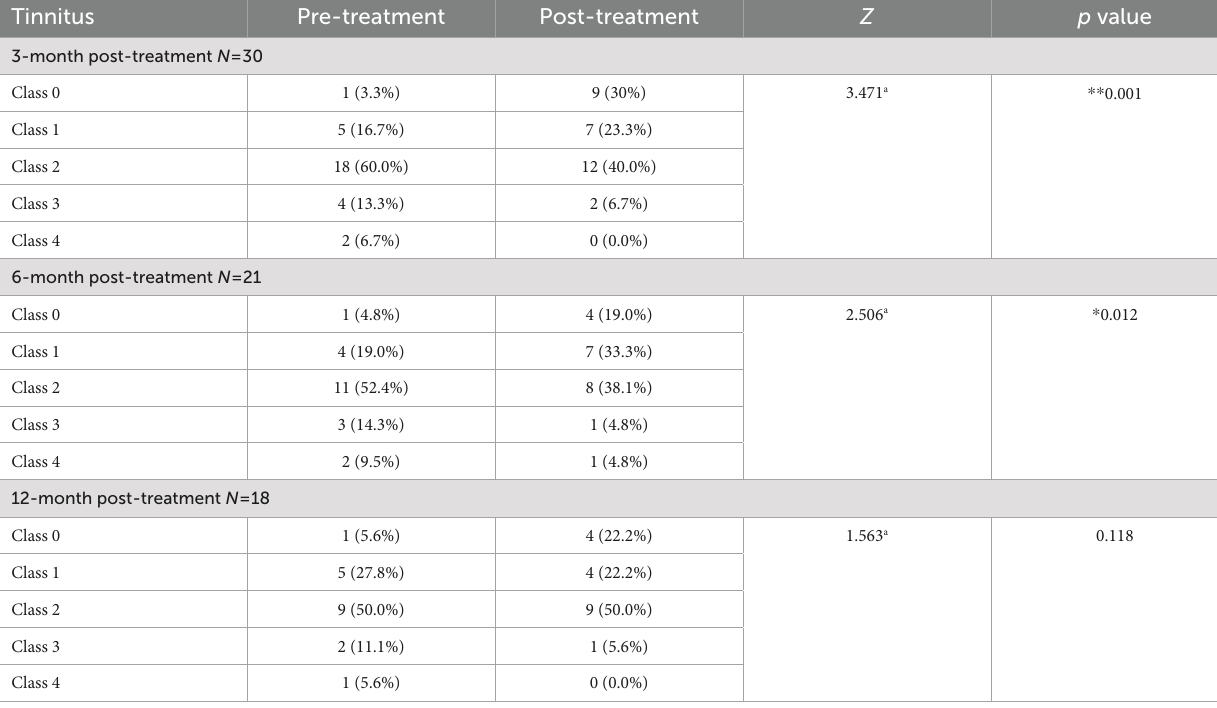
TABLE 4 Comparison of degree of tinnitus pre- and post-treatment for MD patients. Tinnitus Pre-treatment